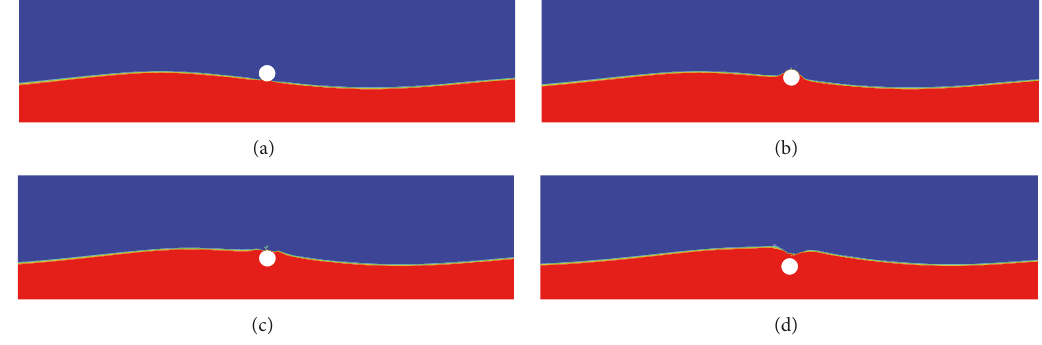
Figure 6: Water entry process of a circular cylinder: (a) 𝑉 𝑑 𝑡/𝑅 = 0 ; (b) 𝑉 𝑑 𝑡/𝑅 = 0.5 ; (c) 𝑉 𝑑 𝑡/𝑅 = 1 ; (d) 𝑉 𝑑 𝑡 𝑡/𝑅 = 2